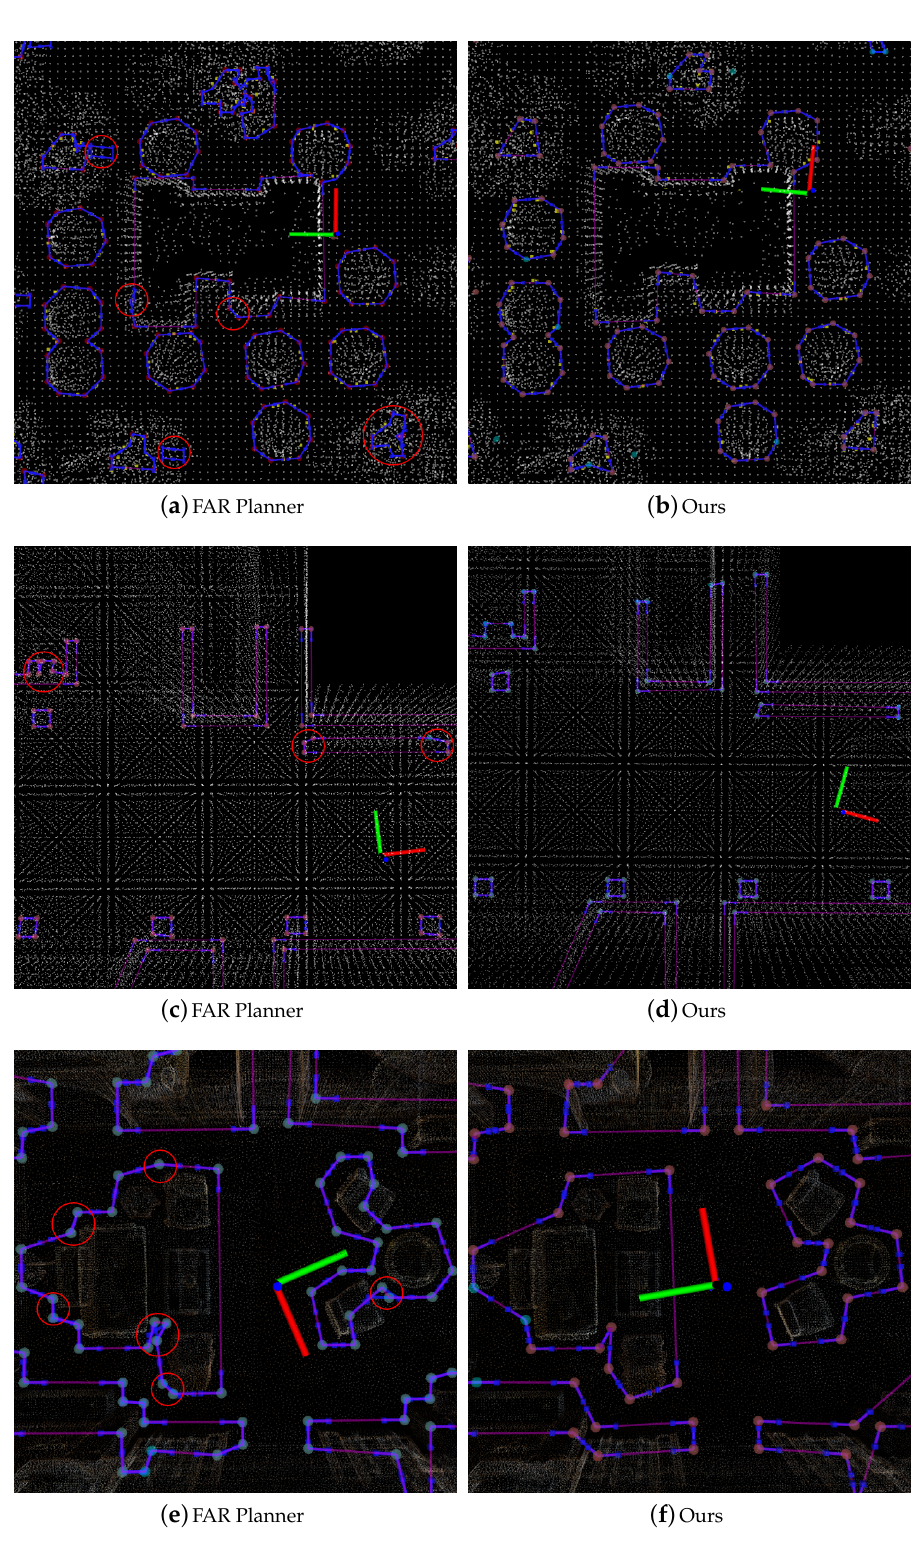
Figure 19. From ( a – f ) is the comparison result of the extracted obstacle